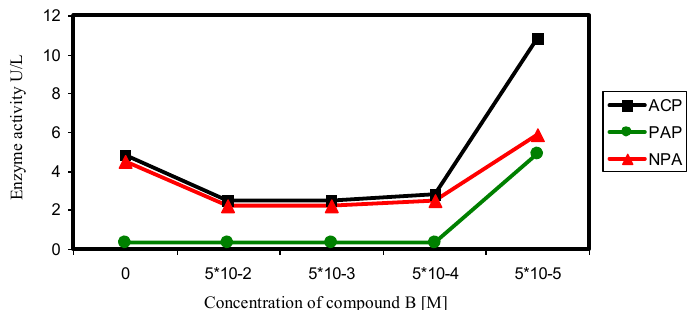
Figure 4. The levels of ACP, PAP and NPA enzymes in the presence of different concentrations of compound